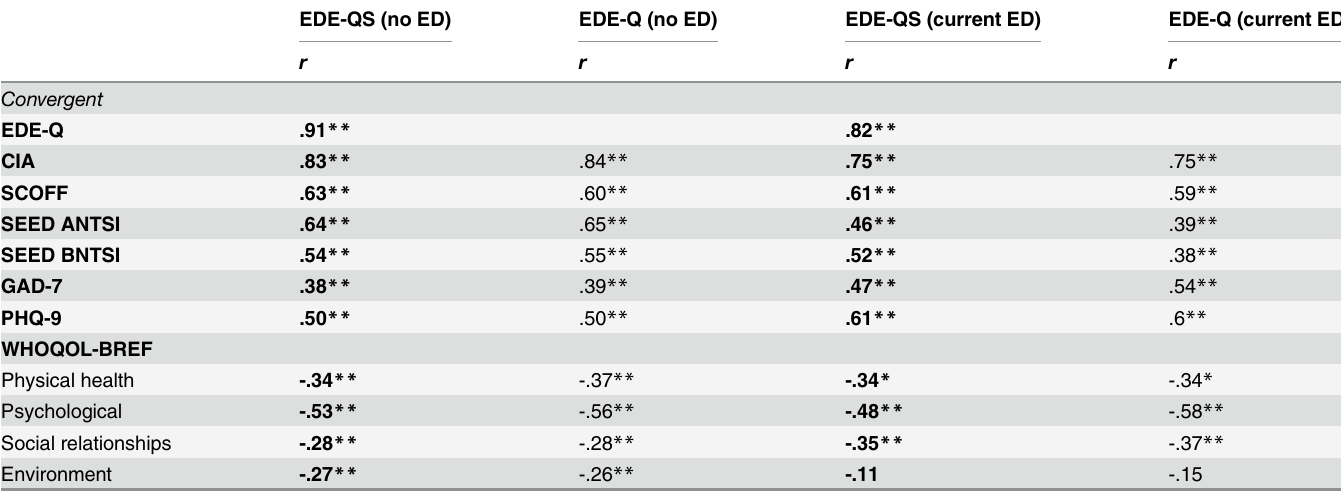
Table 3. Convergent validity correlations for EDE-QS and